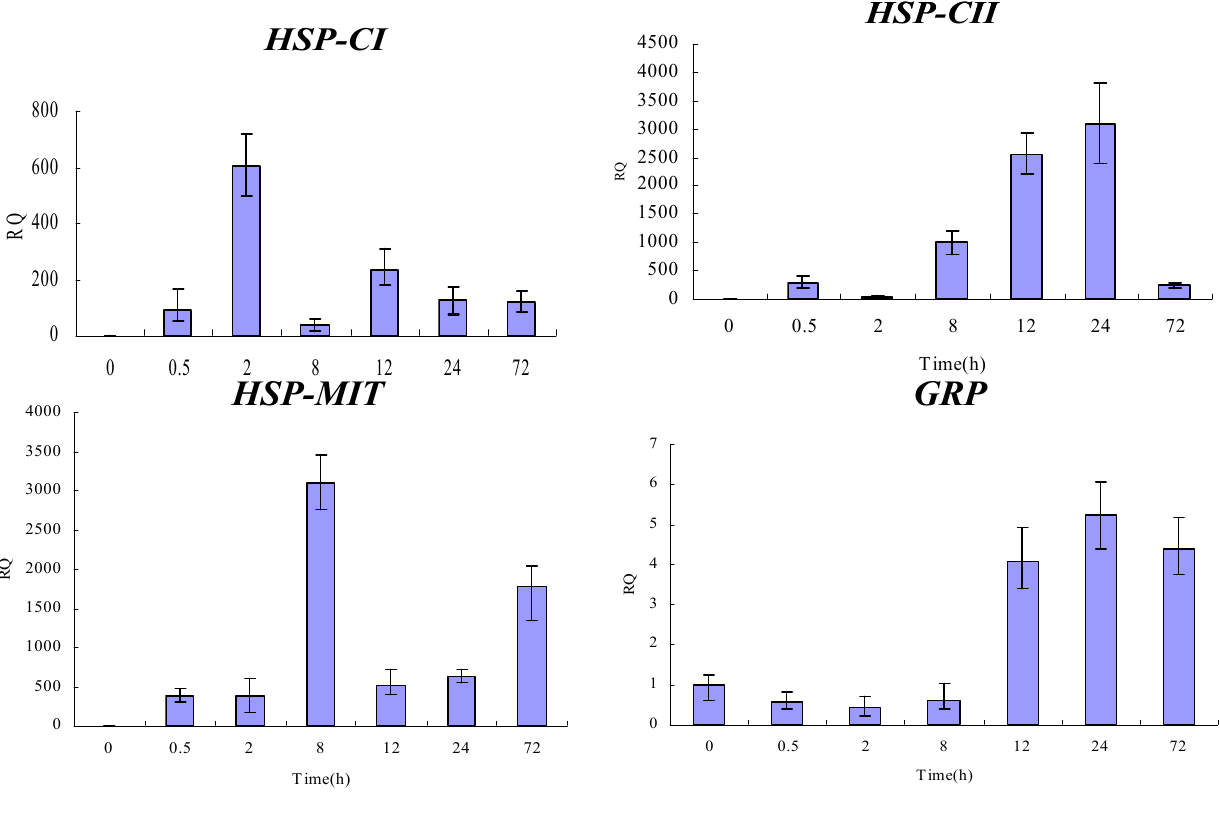
Figure 5. Relative gene expression levels of selected proteins in P. ternata leaves exposed to heat stress for 0, 0.5, 2, 8, 12, 24 and 72 h. The GAPDH gene was used as an internal control. The gene expression levels relative to those in the unstressed state are represented by relative quantification (RQ) values (fold